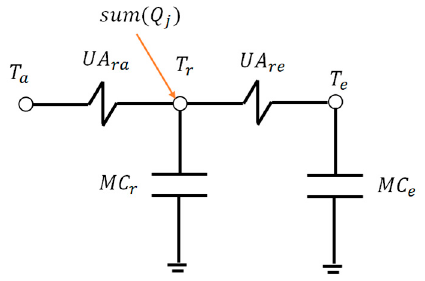
Figure 7. Two-node capacitive building model.